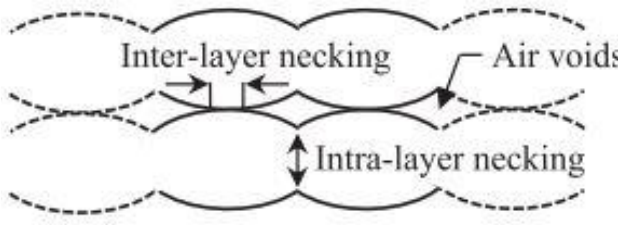
Figure 10. Formation of air void between printed layers. Reprinted with permission from [32], 2017, Elsevier, Amsterdam, The Netherlands.